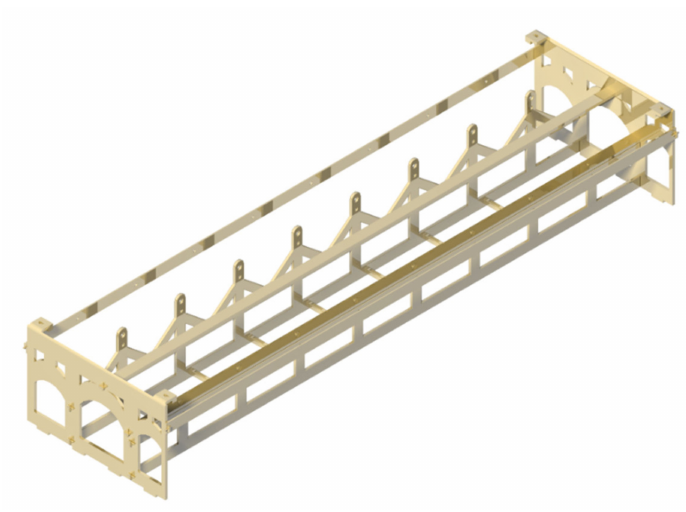
Figure 14. Structure of the assembled